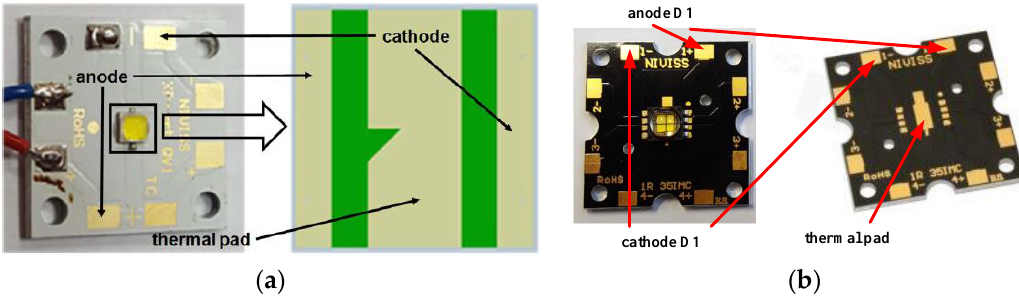
Figure 3. ( a ) View of the metal core printed circuit board (MCPCB) with the XPLAWT LED and the view of this LED electrode layout for this LED; ( b ) view of the MCE LED soldered to the MCPCB and the layout of this MCPCB.